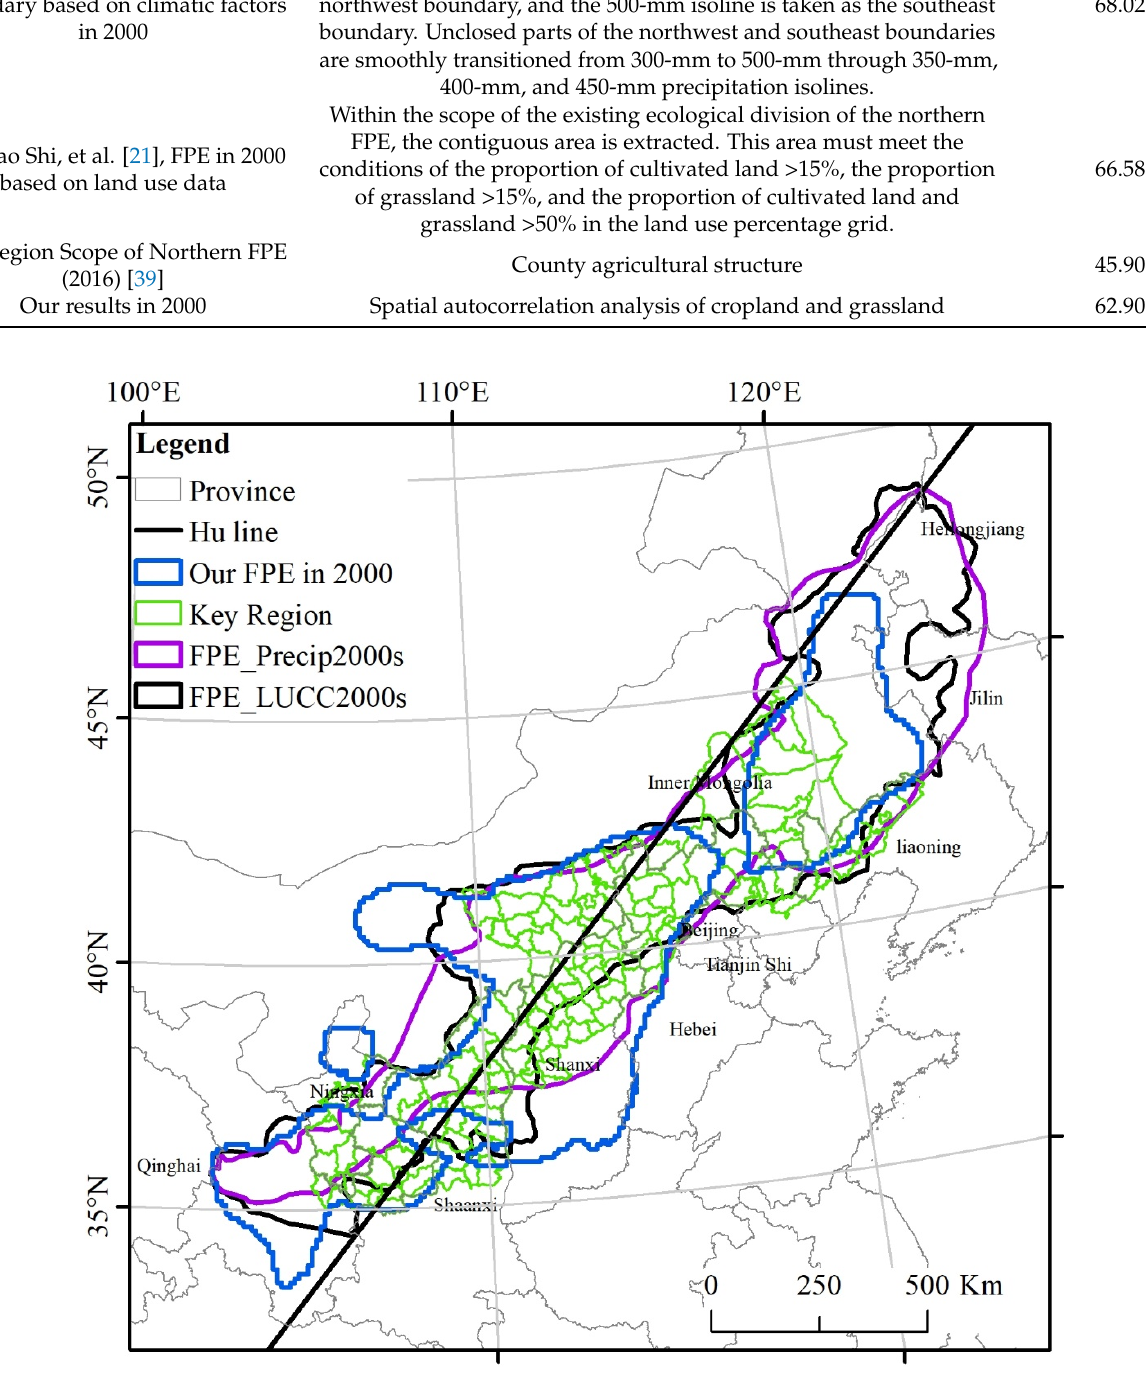
Figure 10. The spatial distribution of FPE with different criteria. Our FPE in 2000 is our result for the year 2000. Key region is the key area of the northern FPE released by the Ministry of Agriculture of the People’s Republic of China. PRE_Precip2000s is the boundary of the FPE based on climatic factors in 2000. PRE_LUCC2000s is the boundary of the FPE based on land use data in